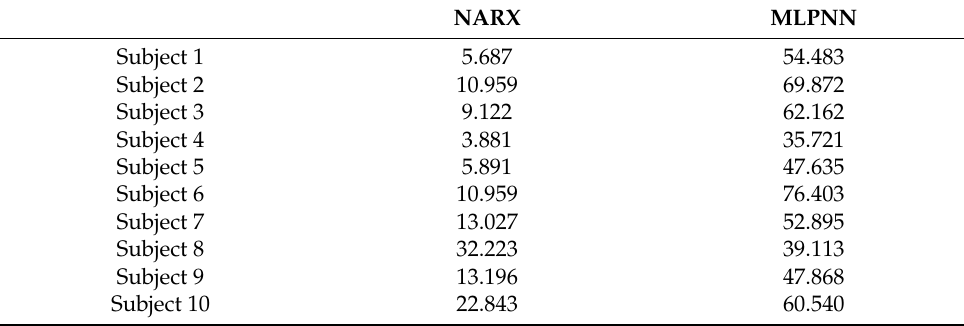
Table 2. MSE of outputs of the NARX model and ordinary multilayer perception neural network (MLPNN) model over